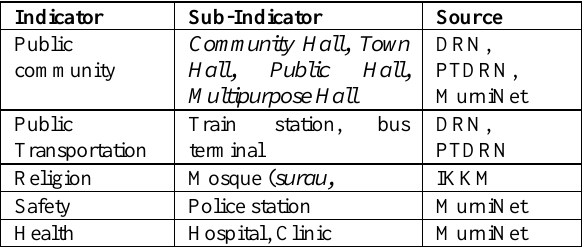
Table 1: The indicators and sub-indicator of social aspect